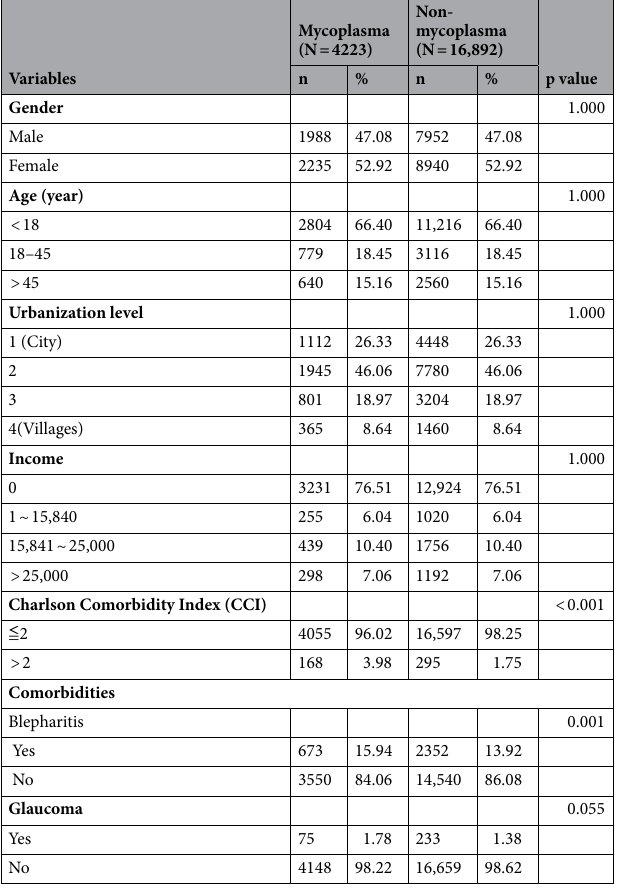
Table 1. Demographic characteristics of and comorbidities in patients with and without Mycoplasma pneumonia enrolled in Taiwan’s National Health Insurance Research